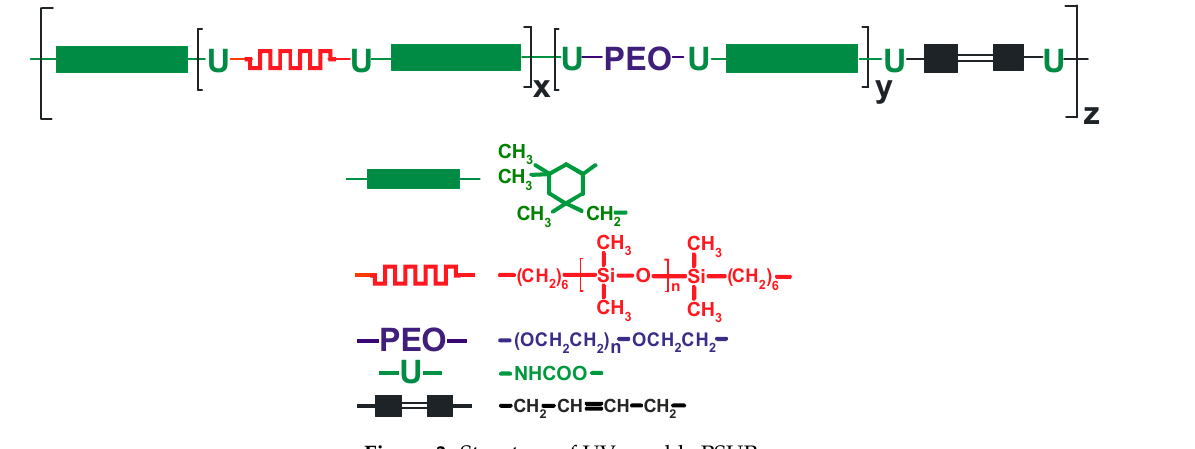
Figure 3. Structure of UV-curable PSUR.